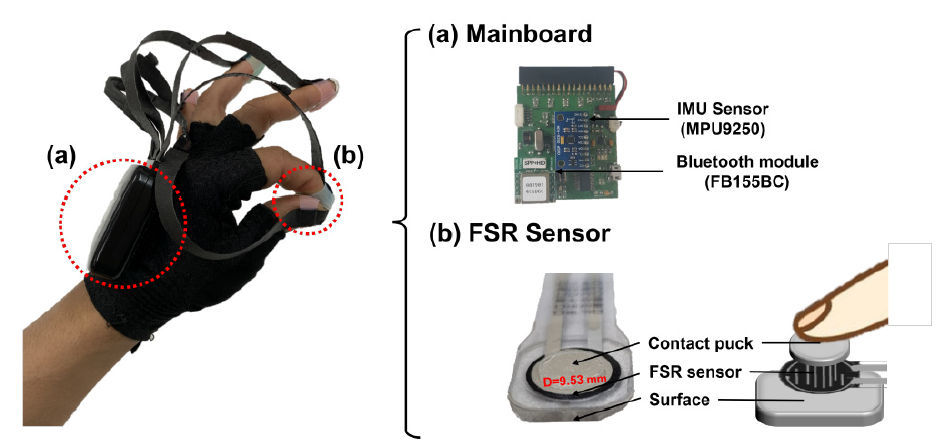
Figure 4. Prototype of the pinch gloves comprising FSR